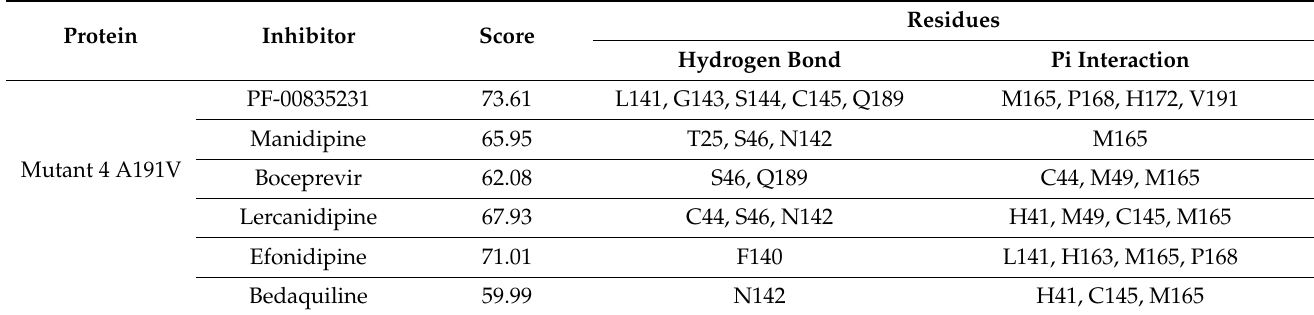
Table 5. The binding details of all compounds against the Mutant 4 (A191V) Mpro.